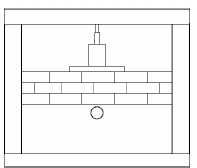
Figure 2. The experimental set up for the overburden EPS blocks